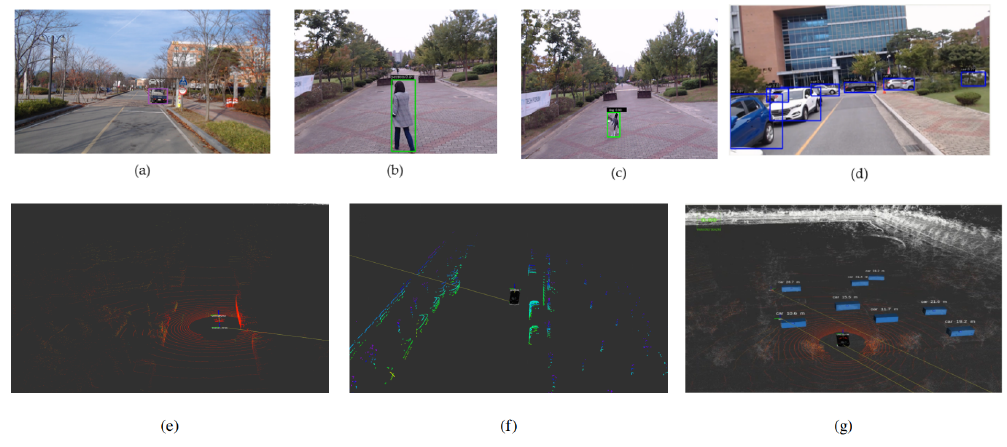
Figure 8. ( a – d ) The object detection result using YOLOv3. ( e ) shows lidar point cloud, ( f ) shows the results for ground plane removal and ( g ) shows the results of PointPillar (Best viewed in color).